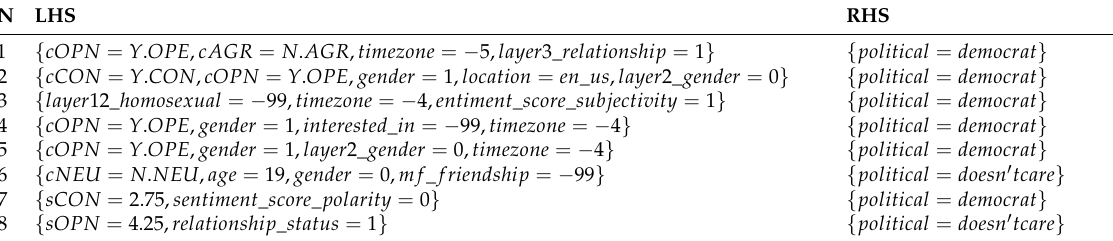
Table 4. Example of rules based classification on myPersonality (political view dataset). N LHS